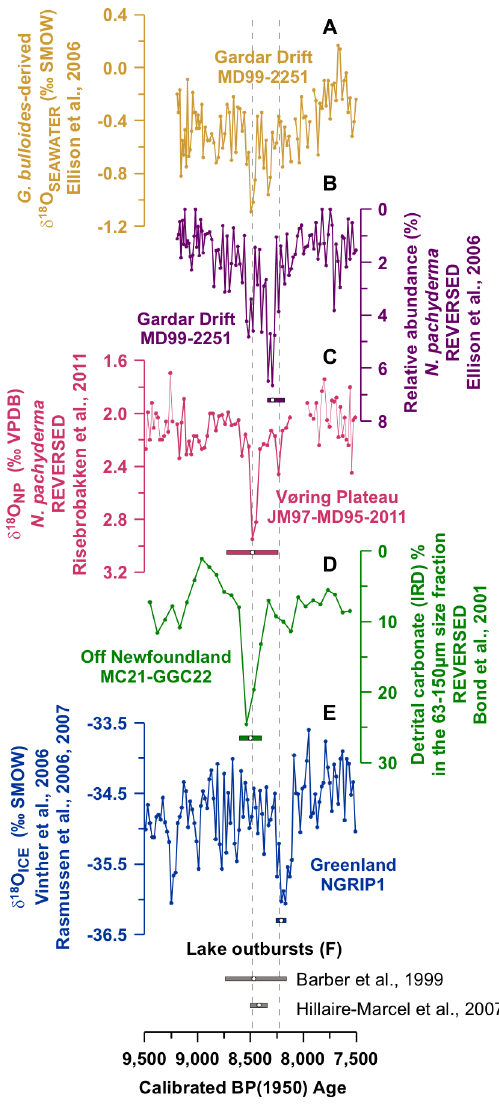
Figure 9. The double-pulse nature of (sub)surface-ocean cooling. (a) The twin surface-ocean freshening events and (b) the unique twin (sub)surface-ocean cooling events at Gardar Drift in the sub- polar North Atlantic (Ellison et al., 2006a). (c) The unique, abrupt (sub)surface-ocean cooling event at 8481 ± 201years BP and the less significant second event at 8233 ± 201years BP at the mid- Norwegian Margin (Risebrobakken et al., 2003e). (d) Ice rafting off Newfoundland (Bond et al., 2008). (e) Cooling over Greenland (Rasmussen et al., 2006; Rasmussen et al., 2007; Vinther et al., 2006). (f) Lake outbursts (Barber et al., 1999; Hillaire-Marcel et al., 2007). The horizontal bars below the records denote the ± 1 σ errors in the respective age models. The dashed vertical lines highlight the two (sub)surface-ocean cold events at the Vøring